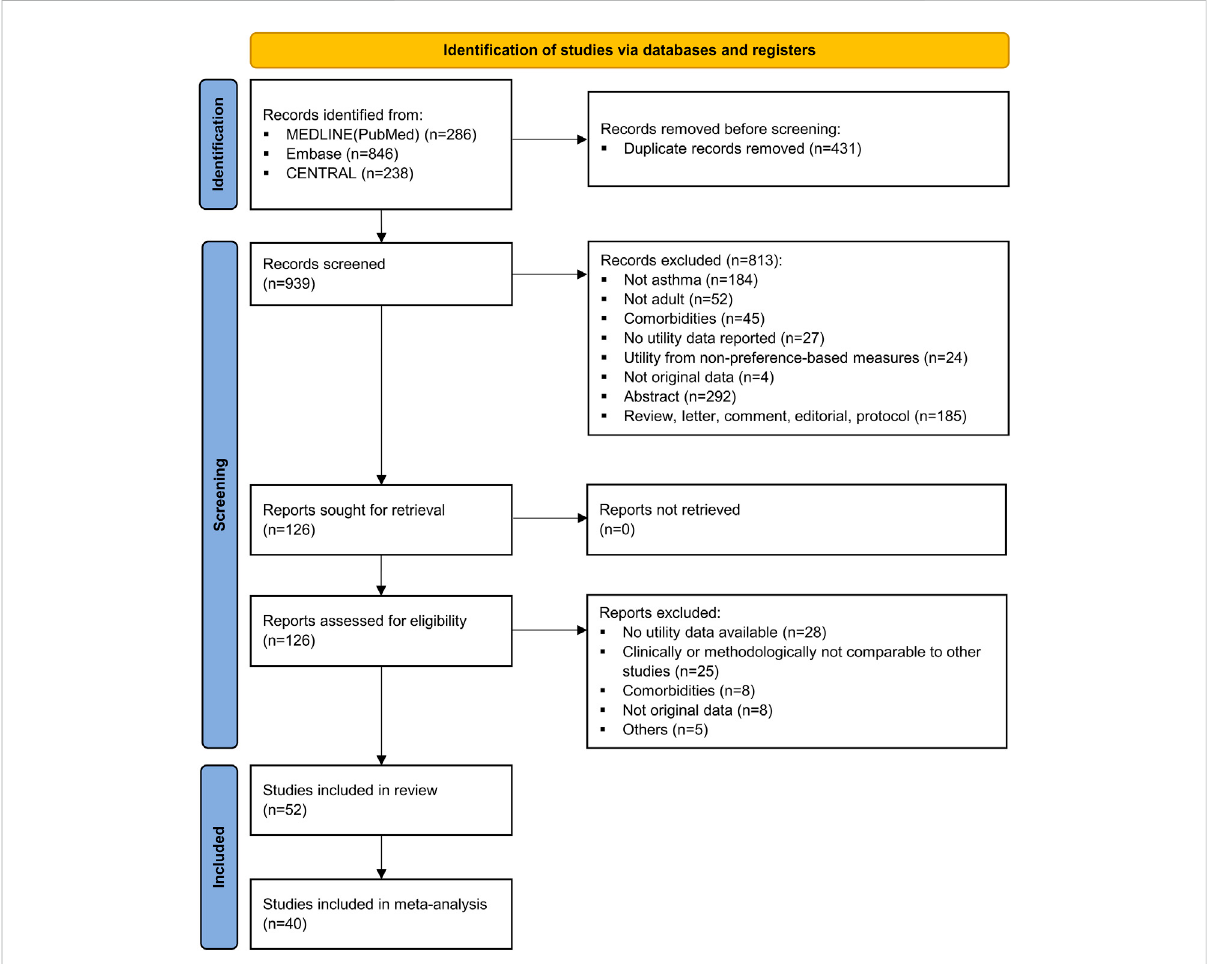
FIGURE 1 PRISMA fl ow diagram of study selection. CENTRAL, Cochrane Central Register of Controlled Trials; PRISMA, Preferred Reporting Items for Systematic Review and